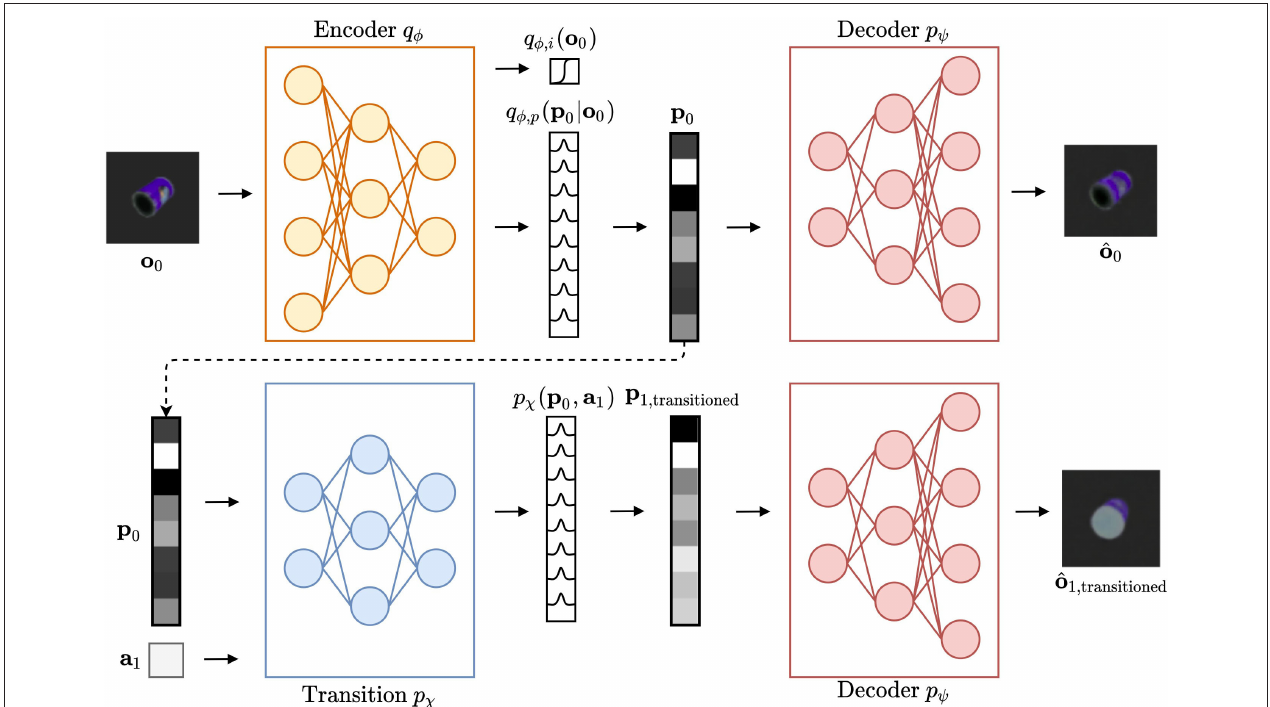
FIGURE 3 | A Cortical Column Network (modeling a master chef can). In the top left, an observation o 0 is provided to the encoder model q φ . This model predicts the distribution over identity as Bernoulli variable to be either belonging to the dedicated object category (i.e., master chef can) or not. Secondly, a distribution over the latent pose variable p 0 is predicted. A sample p 0 from this distribution is then decoded through the decoder p ψ and provides the reconstruction ˆ o 0 . Using the transition model p χ , this pose sample is transitioned into a belief over the latent pose variable p 1,transitioned , given action a 1 . A sample from this new belief over p 1,transitioned is also decoded into an expected view ˆ o 1,transitioned